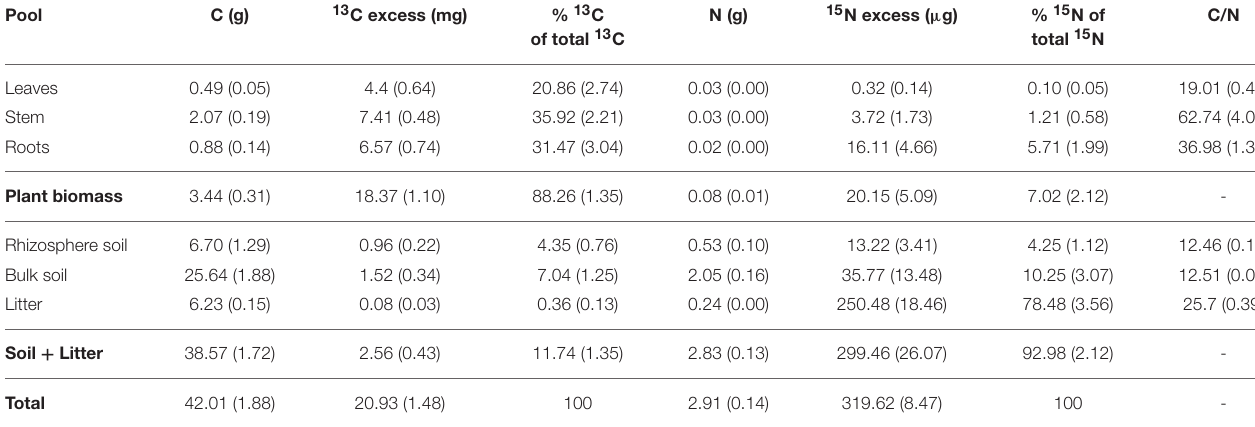
FIGURE 2 | Bar graph illustrating the proportion of ECM fungal orders in total ECM fungal communities in litter samples derived from planted (dark blue) and unplanted boxes (gray), as well as from the rhizosphere soil (light blue) as average proportion of the libraries ± standard error (SE). The insert graph depicts the proportion of ECM fungi in the total fungal communities (average proportion of the libraries ± SE). TABLE 1 | Total C, 13 C, N, and 15 N per box (in absolute values), percent of total 13 C and 15 N showing allocation of recent photosynthates and N from the litter compartment in bulk pools, and C/N ratio of bulk